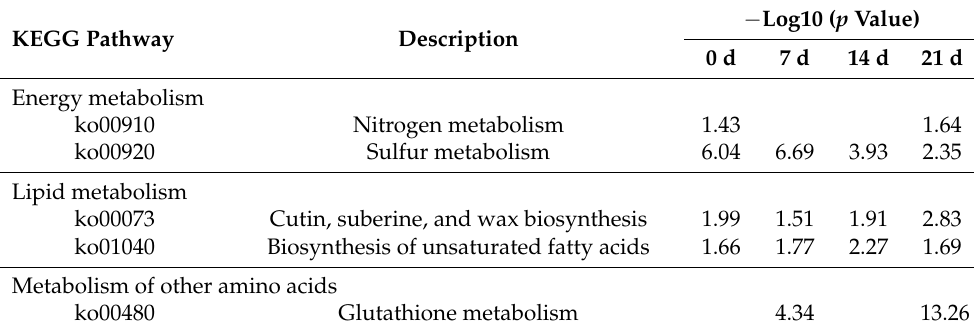
Figure 5. KEGG pathway enrichment analysis of DEGs at all time points in A9-29 versus Hua30 under low-N stress. Table 1. The major KEGG pathway enrichment for upregulated DEGs in A9-29 versus Hua30 under low-N